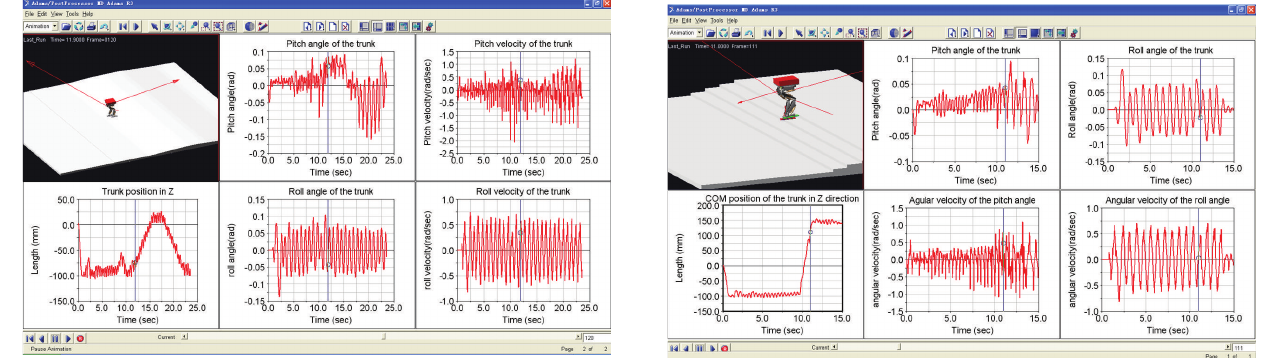
Figure 11: Walking up